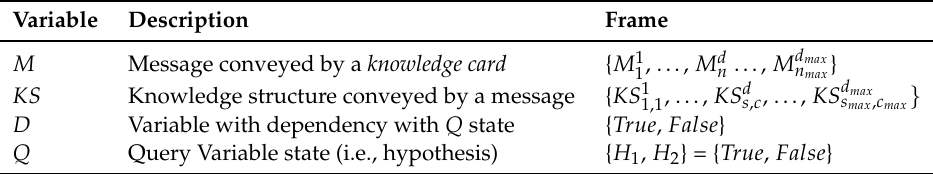
Table 1. MARItime Surveillance knowledge Acquisition (MARISA) Game state.